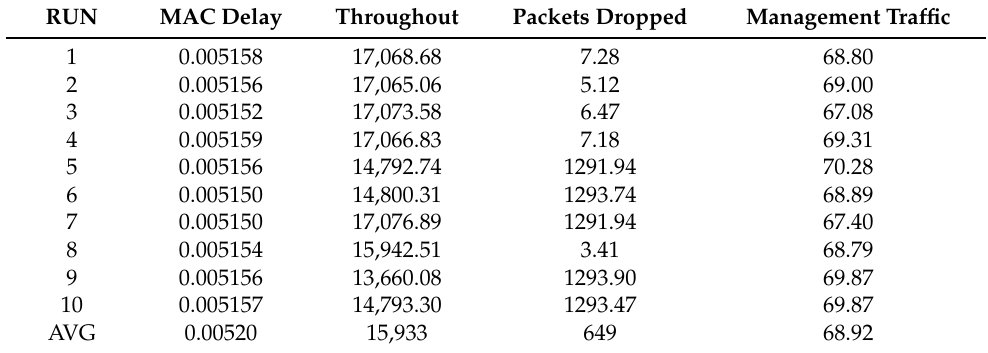
Table 5. Simple Scenario IACO.